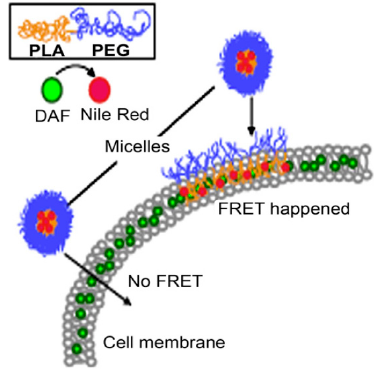
Figure 7. Förster resonance energy transfer will only occur if the micelles release their core loaded drug (Nile red, acceptor) into the DAF (donor) labelled cell membrane (Adapted from Reference [107] with permission from Elsevier).